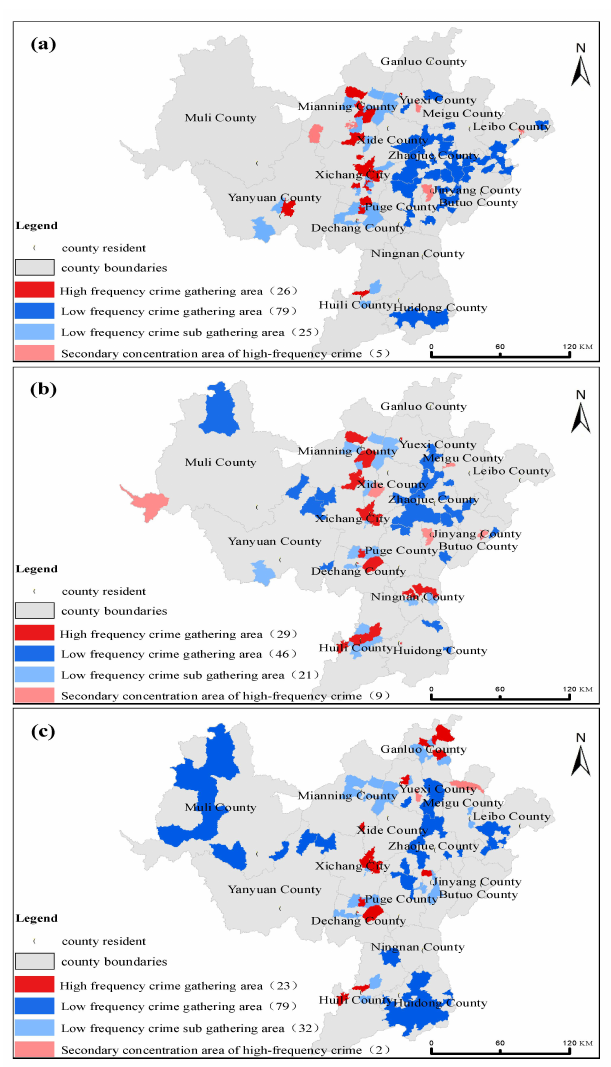
Figure 6. Local spatial autocorrelation results for the various crime: ( a ) Property crime; ( b ) Violent crime; ( c ) Special crime; The figures in brackets represent the number of crimes of all